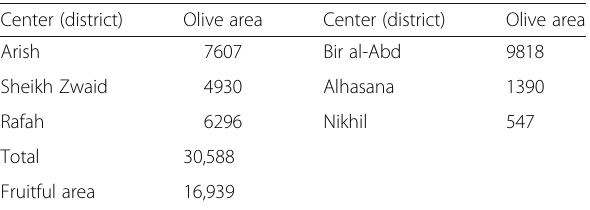
Table 1 Olive areas in North Sinai Governorate for the 2013/ 2014 season